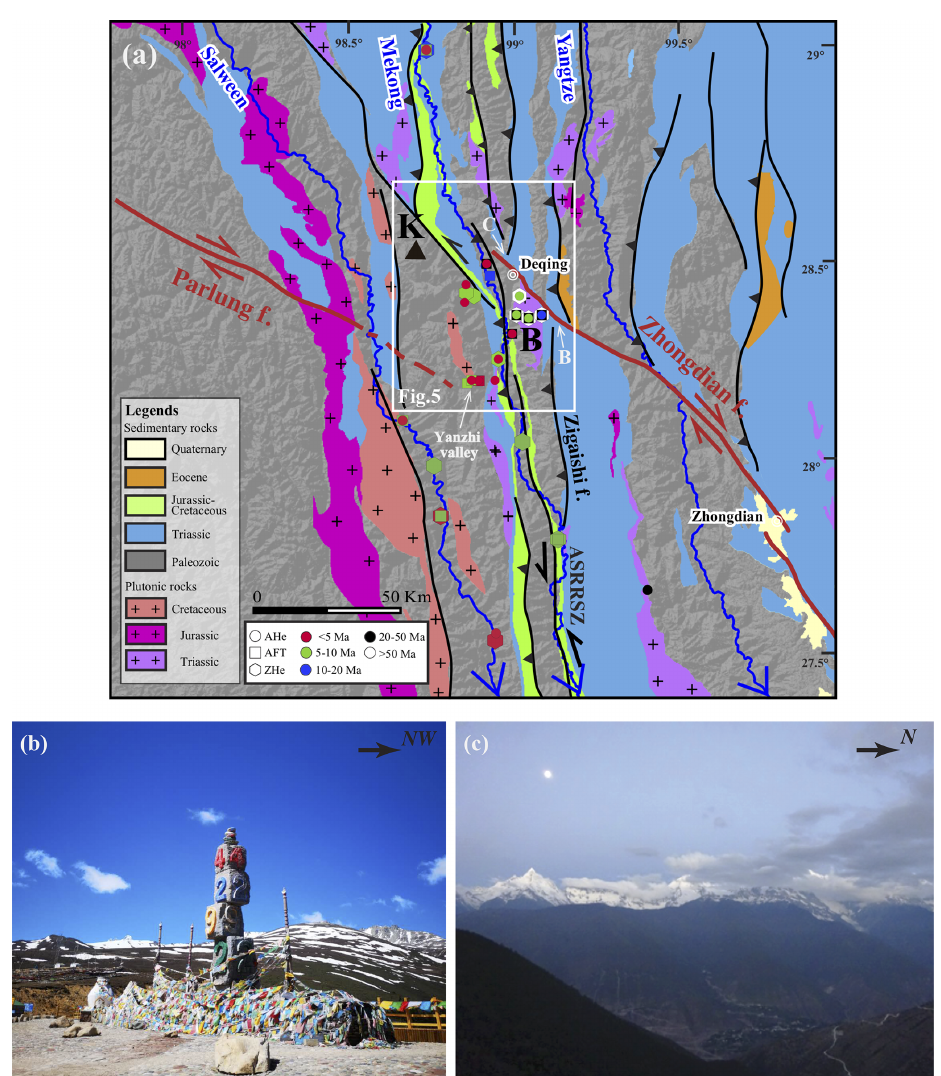
Figure 2. (a) Geological map of the Kawagebo area in the Three Rivers Region. Active faults are in red, other major faults in black. Thermochronology data are shown with colour according to age and symbol according to method. ASRRSZ: Ailao Shan–Red River Shear Zone; K: Kawagebo massif; B: Baima Xueshan massif. (b) View of the low-relief Baima Xueshan massif at ∼ 4500m mean elevation, with summits peaking at ∼ 5400m visible at the background. (c) View of high-relief Kawagebo massif, with summit peaking at 6740m, while the Mekong River valley lies at ∼ 2000m elevation, creating almost 5000m of